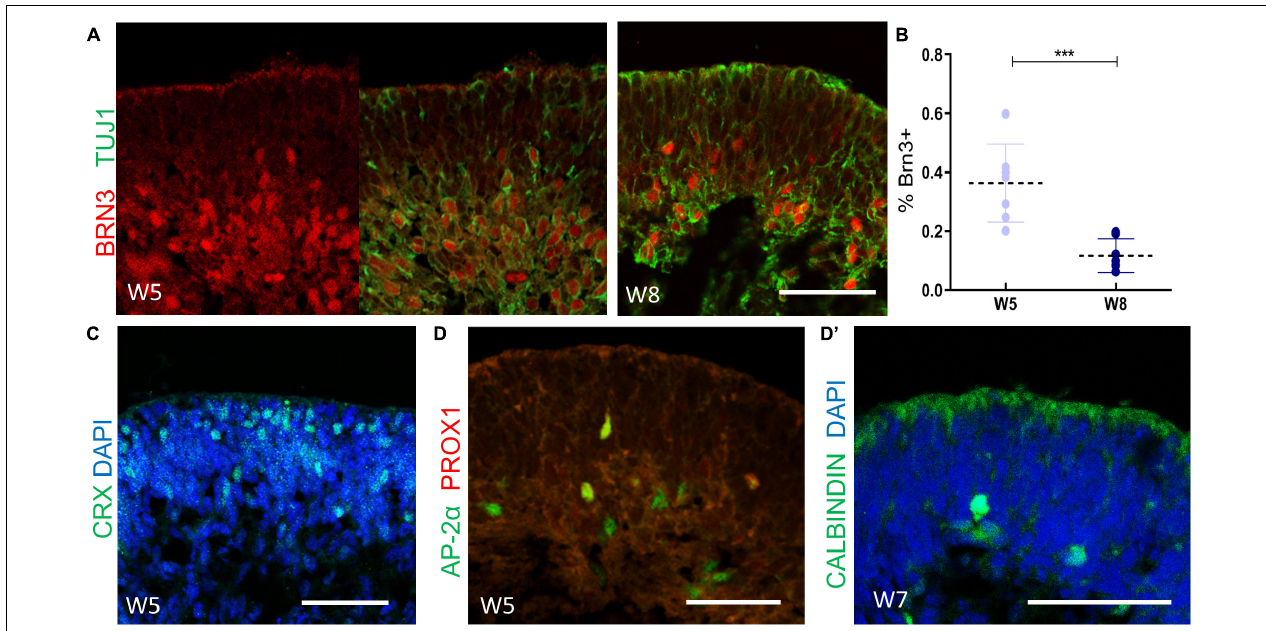
FIGURE 3 | The cellular composition of retinal organoids during the early-stage differentiation. (A) The cellular dynamics of retinal ganglion cells were marked at Week 5 (BRN3, red; TUJ1, green), and Week 8 (BRN3, red; TUJ1, green). (B) Statistics analysis of the ratio of BRN3 + cells versus total cells (marked by DAPI) at Week 5 and Week 8, respectively. Mean ± SD, *** P < 0.0005. (C) Localization of CRX + cone photoreceptor cells at Week 5. (D) The onset of AP2 α + amacrine cells and AP2 α + /PROX1 + horizontal cells were detected (AP-2 α , green; PROX1-red) at Week 5 and confirmed by CALBINDIN (green, D’ ) staining at Week 7. Scale bar = 50 µ